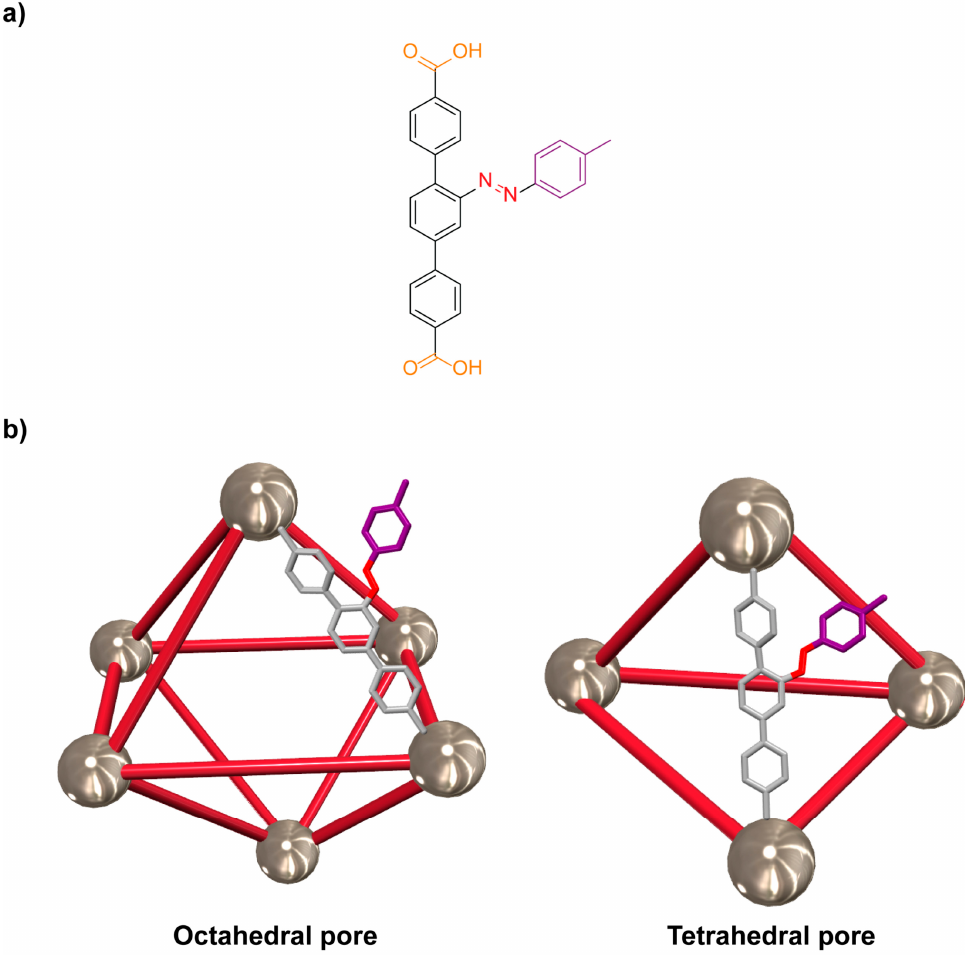
Figure 4. ( a ) Chemical structure of the azobenzene ligand 2 ; ( b ) cartoon representation of the octahedral and tetrahedral pores of the azobenzene-functionalized thorium organic framework Th-Azo-MOF [63]. For clarity, only the structure of one organic ligand per pore is shown. Color key: metallic grey = thorium clusters; red = rods representing the azobenzene ligand 2 and nitrogen atoms of the azo functionality; light grey = carbon atoms; white = hydrogen atoms; purple = phenyl